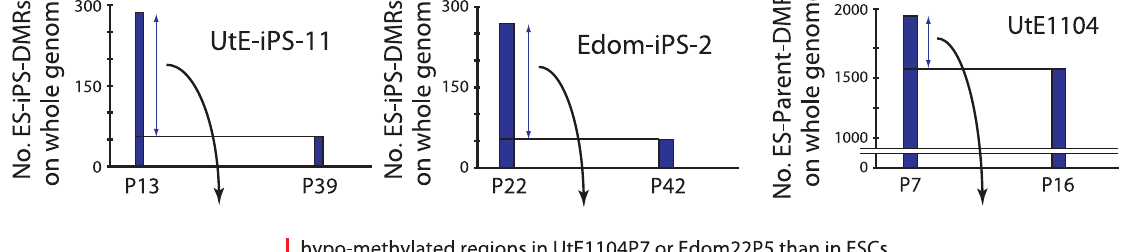
Figure 5. Number of the ES-iPS-DMRs and ES-parent-DMRs with passaging. ( A ) Number of the ES-iPS-DMRs with passaging. Red line plots indicate total number of the ES-iPS-DMRs. Blue bars indicate the number of the ES-iPS-DMRs that appeared at the earliest passage. Orange, green and red bars indicate the number of the ES-iPS-DMRs that appeared secondarily at later passages. Appearance/disappearance of the ES-iPS-DMRs and inherited regions were repeated, but the number of newly-appeared ES-iPS-DMRs was decreased with passaging. ( B ) Number of the ES-parent-DMRs with passaging. Blue bars indicate the number of the ES-parent-DMRs at P5 (or P7). Orange and green bars indicate de novo ES-parent-DMRs at P11 and P16, respectively.